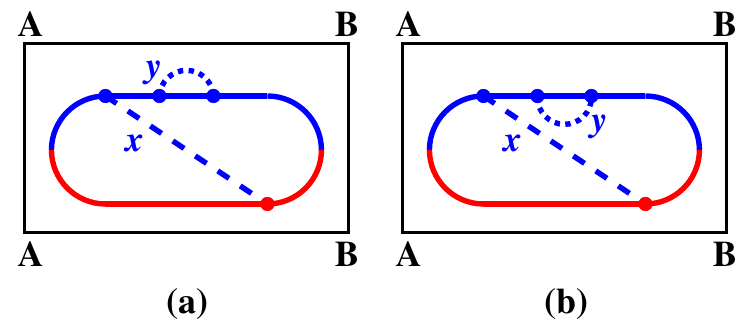
Figure 19 . The two large- N c color routings of the A1 diagram, analogous to the treatment of the xy ¯ x ¯ y diagram in section 2.2.1 of ref. [15]. Here we imagine drawing our time-ordered large- N c diagrams on a cylinder, as in ref. [15]: the top edge AB of the each rectangle should be identified with the bottom edge AB. In the large- N c limit, medium interactions (not drawn) are correlated between each pair of high-energy particle lines that are neighbors as one circles the cylinder.